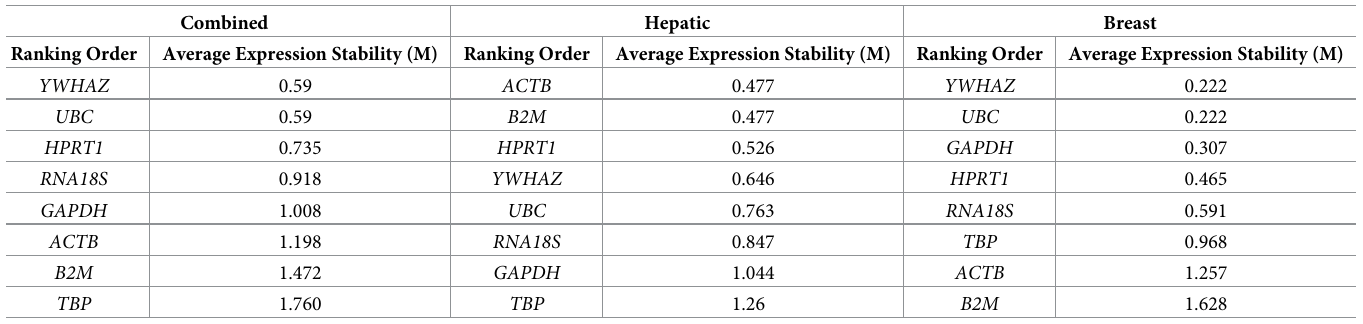
To provide NormFinder input data, the mean Cq values of all samples for each reference gene were transformed to the linear scale expression quantities according to the producer’s instruc- tion. The lowest expression stability value exhibits the most stable reference gene. As shown in Fig 2B and Table 4, in hepatic cancer cell lines, B2M , GAPDH , UBC , and HPRT1 were the first four stable nominees, respectively, and RNA18S was determined as the least stable ones. In breast cancer cell lines, GAPDH , TBP , and UBC were the most stable reference genes almost Table 3. Stability ranking order of nominee reference genes determined by GeNorm algorithm. Combined Hepatic Breast Ranking Order Average Expression Stability (M) Ranking Order Average Expression Stability (M) Ranking Order Average Expression Stability (M)